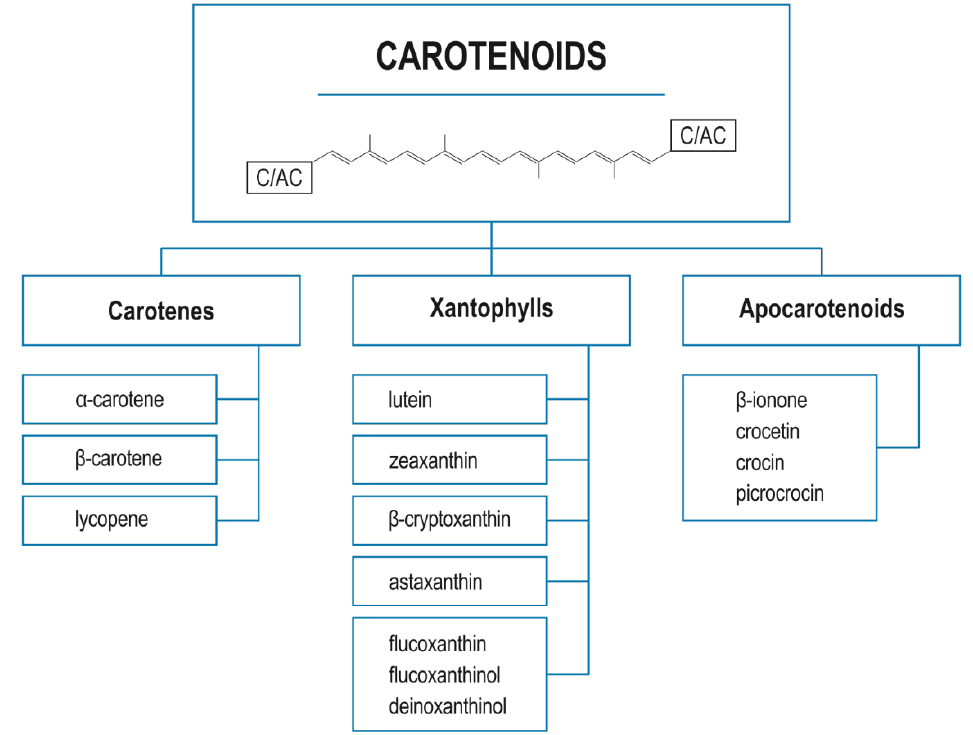
Figure 1. A classification of the major representatives of the carotenoids, viz. carotenoids, xantho- phylls, and apocarotenoids. C/AC: cyclic/acyclic end groups differ in individual carotenoids. Their structure is based around eight isoprenoid units with conjugated double bonds.